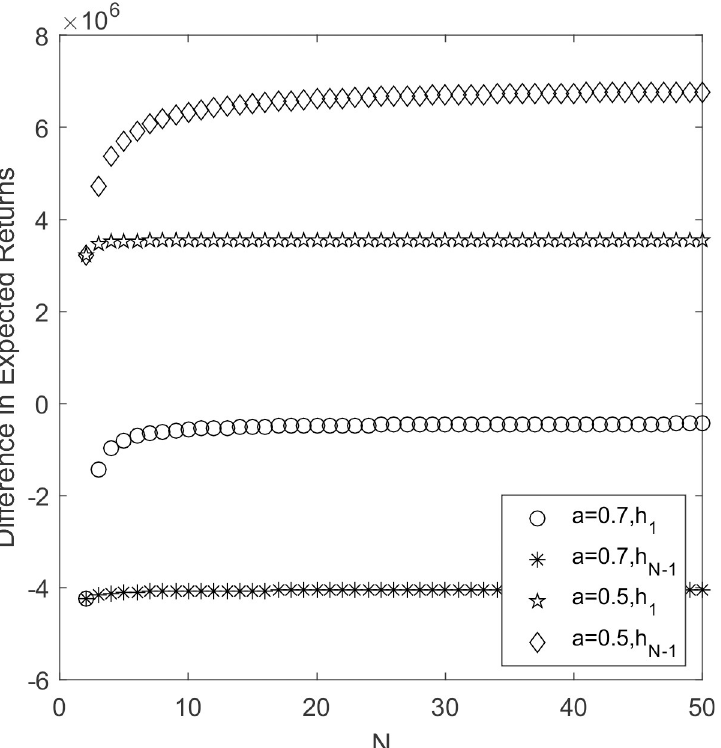
Fig 1. h 1 / h N -1 ~ a change